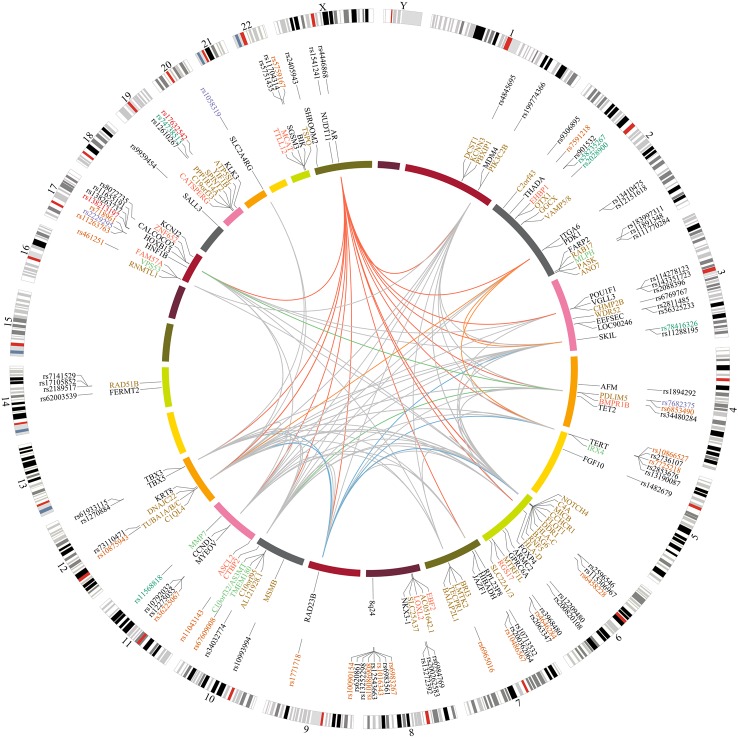
Circos plot overview of functional annotation and eQTL data for fine-mapped PrCa risk loci generated using Circos (http://circos.ca/, 62). The outer ring is a circular ideogram of the human genome annotated with chromosome number. The positions of the novel index SNPs for PrCa susceptibility identified through fine-mapping are indicated adjacent to this and are color coded for overlap with enhancer elements in LNCaP in orange, promoter regions in green, coding SNPs in red, variants within UTR regions in purple and variants with no annotated functionality in black. The inner ring denotes potential candidate genes for the refined PrCa regions. Genes for which an SNP in the best candidate list is a significant eQTL in prostate tissue in TCGA data are indicated in red, eQTLs in skin tissue from EuroBATS data are marked in brown, eQTLs for both prostate and skin in green and for regions with no significant eQTL in either tissue the closest flanking gene is indicated in black. Gene interaction networks between potential candidate genes are shown as links in the central portion of the plot. The genes annotated on the inner ring were used to construct a network using the BioGRID interaction database filtered to exclude ubiquitin and interactions with more than a single intervening gene between the candidate genes. Red links indicate an interaction network with the AR gene, other examples of interaction highlighted in color: blue—RAD23B, green—BMPR1B, orange—PDK1 and all other interactions are marked in gray.